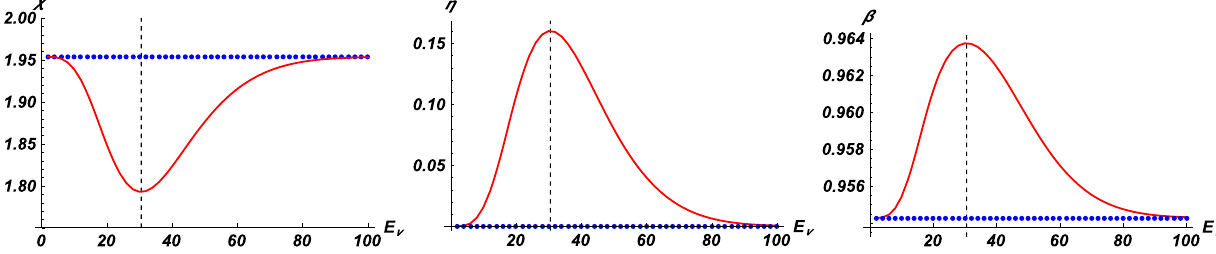
Fig. 2 Neutrino system (LSND decoherence model). Coherence parameter χ(ρ) (left), mixedness parameter η(ρ) (middle) and com- plementarity parameter β(ρ) (right), plotted as a function of neutrino energy E ν (MeV) with CP violating phase δ = 0. The maximum value